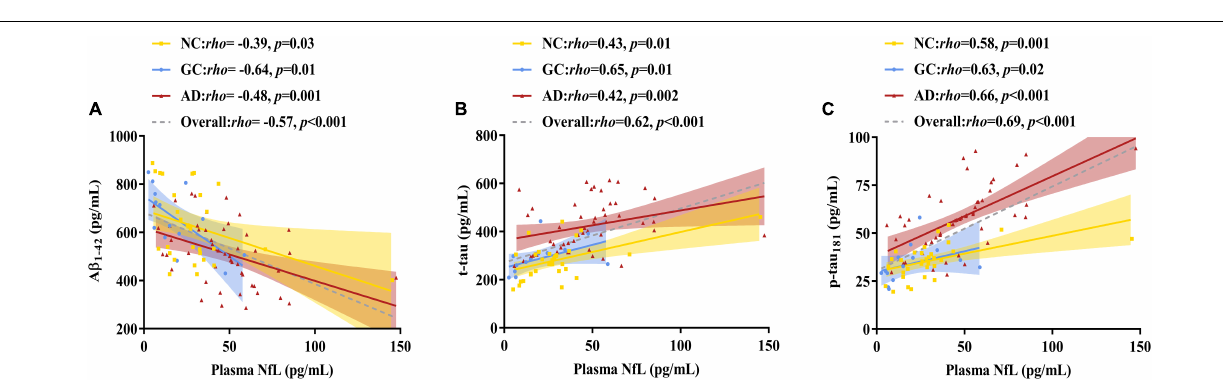
FIGURE 3 | Correlations between plasma NfL levels and CSF pathological biomarker levels. (A) Relationship between plasma NfL and A β 1 − 42 . (B) Relationship between plasma NfL and t-tau. (C) Relationship between plasma NfL and p-tau 181 . Spearman’s rank correlation test was employed. The numbers are the Spearman correlation coefficients. The symbol “n.s.” indicates no significant association. NfL, neurofilament light chain; A β 1 − 42 , amyloid β -protein 1–42; t-tau, total tau; p-tau 181 , phosphorylated tau 181; NC, normal control; GC, gastric cancer; AD, Alzheimer’s disease.